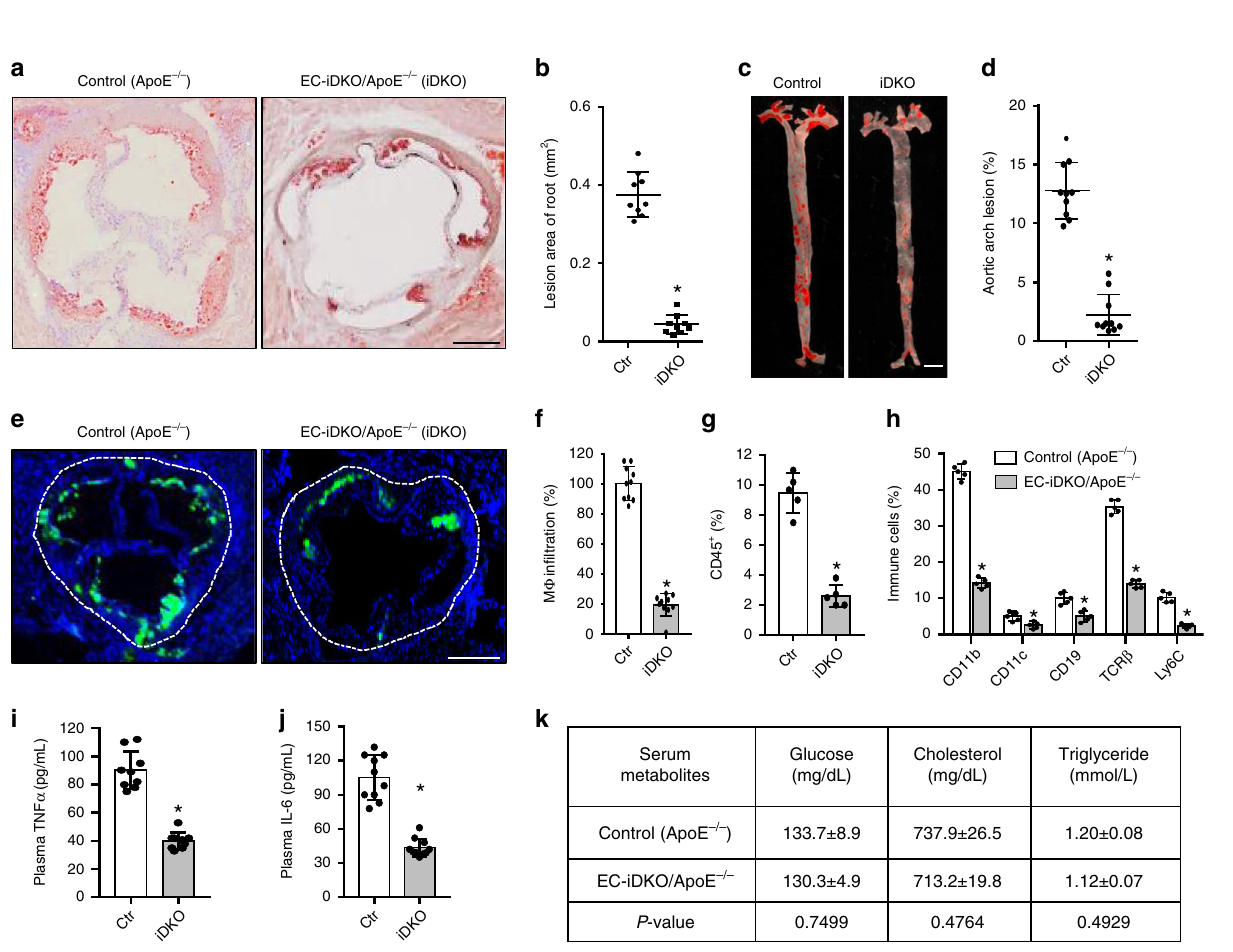
Fig. 5 Deletion of endothelial epsin 1 and 2 inhibits atherosclerosis. a – d Oil Red O (ORO) staining of atherosclerotic lesions in aortic roots ( a ) and arches ( c ) of control (ApoE − / − ) and EC-iDKO/ApoE − / − (iDKO) atherosclerotic mice fed a WD for 12 – 14 weeks. Statistical analysis of aortic root and arch lesions are shown in ( b ) and ( d ), respectively ( n = 9 mice for aortic root, and n = 10 mice for aortic arch analysis, asterisk P < 0.001). Scale bars 500 μ m ( a ) and 5 mm ( c ). e , f Ma c rophage (M Φ ) in fi ltration in aortic roots by immuno fl uorescent staining with the Moma-2 antibody for control and iDKO mice fed a WD ( e ) and quanti fi ed ( f ) ( n = 10 in each group, asterisk P < 0.001). Scale bar 500 μ m. g Immune and in fl ammatory cells in aortic arches were measured using FACS analysis for CD45 + cells. Data are presented as percentage of the total cells analyzed ( n = 5 in each group, asterisk P < 0.05). h Percentage of subtypes of immune cells in aortic arches measured by FACS for control and iDKO mice ( n = 5 mice in each group, asterisk P < 0.001). i , j Serum TNF α and IL-6 levels in control and iDKO mice ( n = 10 in each group, asterisk P < 0.001). k Metabolic parameters in serum ( n = 10 in each group). Statistical analyses were performed using Student ’ s t -test and are presented as the mean ± and LyC-6 positive cells (Fig. 5h). These cells were decreased as a staining and fl ow cytometry, respectively. Immune cell subtypes result of epsin-de fi ciency. Circulating pro-in fl ammatory cytokines identi fi ed from the leukocyte common antigen (CD45 + ) popula- tion collected from the aortas of ApoE − / − and EC-iDKO/ApoE − / − (TNF α and IL-6) were also reduced in EC-iDKO/ApoE − / − mice mice included CD11b, CD11c, CD19, T-cell receptor beta (TCR β ), (Fig. 5i, j). Importantly, the loss of endothelial epsins did not